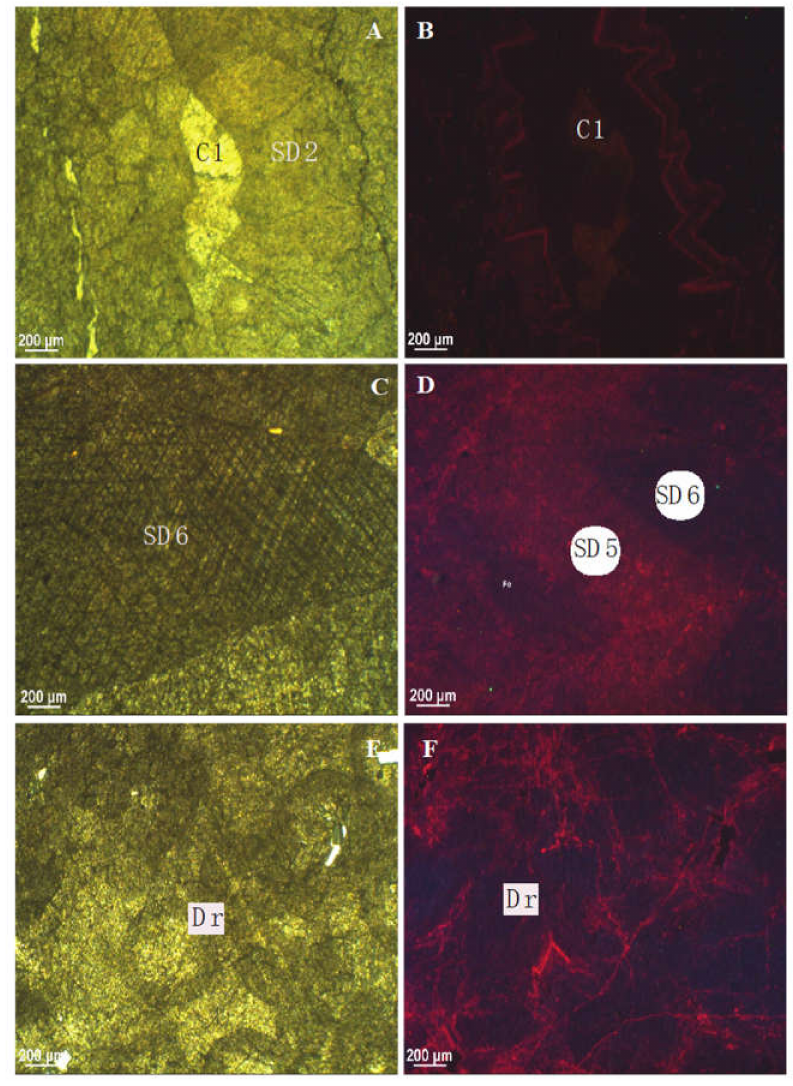
Figure 8. Photomicrograph of ( A ) saddle dolomite (SD2) and calcite (C1) in PPL, calcite overgrowth on the saddle dolomite is clearly highlighted under cathodoluminescence in ( B ). ( C ) Saddle dolomite (SD6) in PPL and ( D ) cathodoluminescence (CL) photomicrograph, illustrating the general pattern in luminescence, including thicker zones of red and nonluminescence with shades of thin bright red luminescence, reflecting formation in pore waters that chemically changed. ( E ) Recrystallized dolomite (Dr) in PPL, ( F ) the same as in ( E ) CL photomicrograph, the recrystallized dolomite shows thick nonluminescent zones with thin bright red luminescent